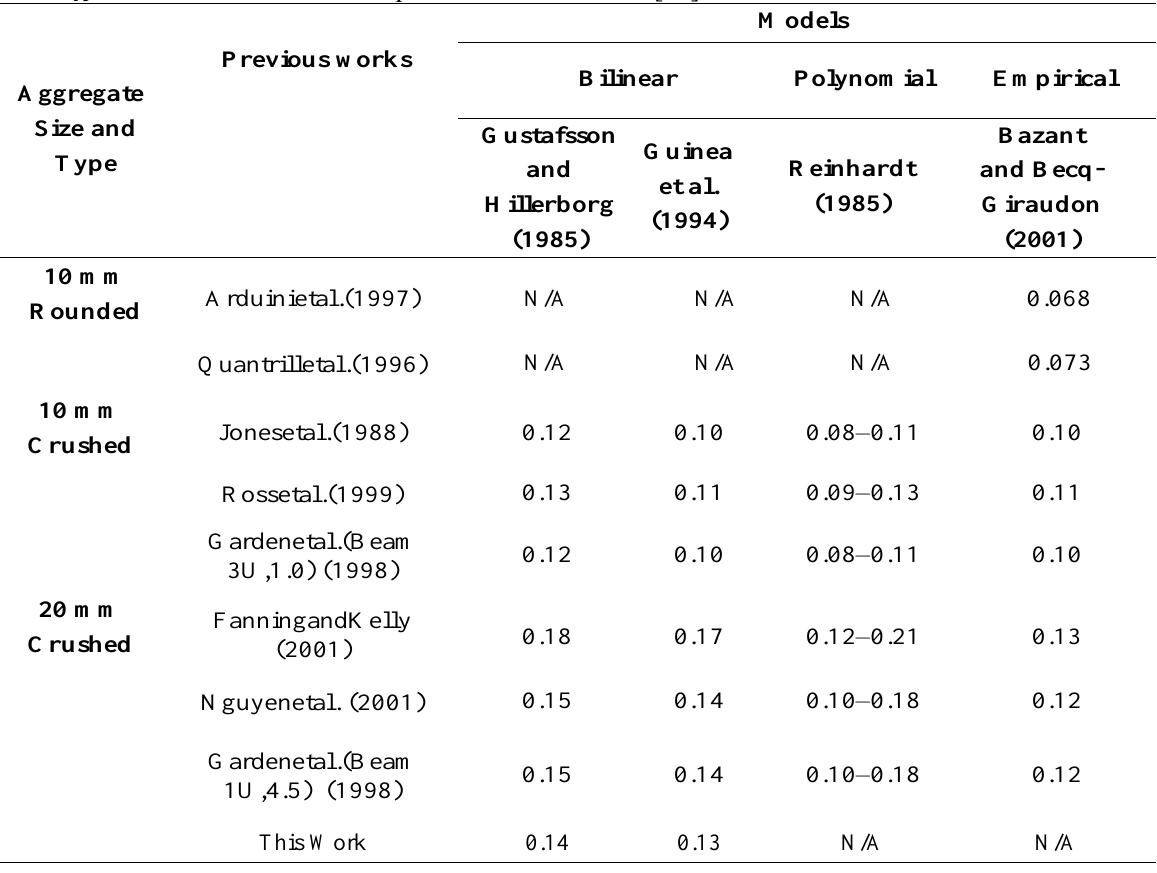
The 𝐺 value based on models for previous and this work 𝐼𝑐